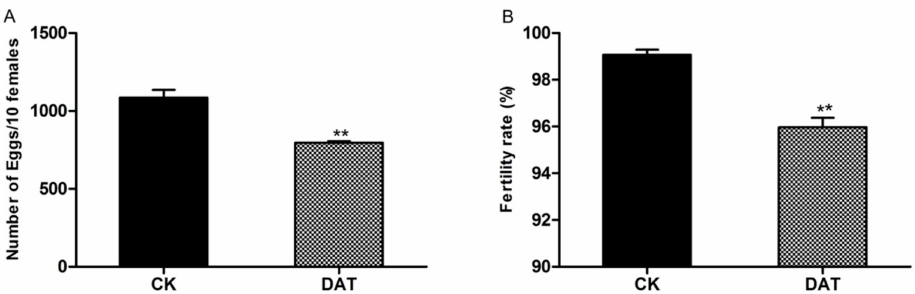
Figure 1. The e ff ect of diallyl trisulfide (DATS) on ( A ) the mean number of eggs laid per day by 10 females and ( B ) the mean number of fertilized eggs, compared to control females (CK). Error bars indicate SEM and ** indicates a significant di ff erence ( p < 0.05, t -test).